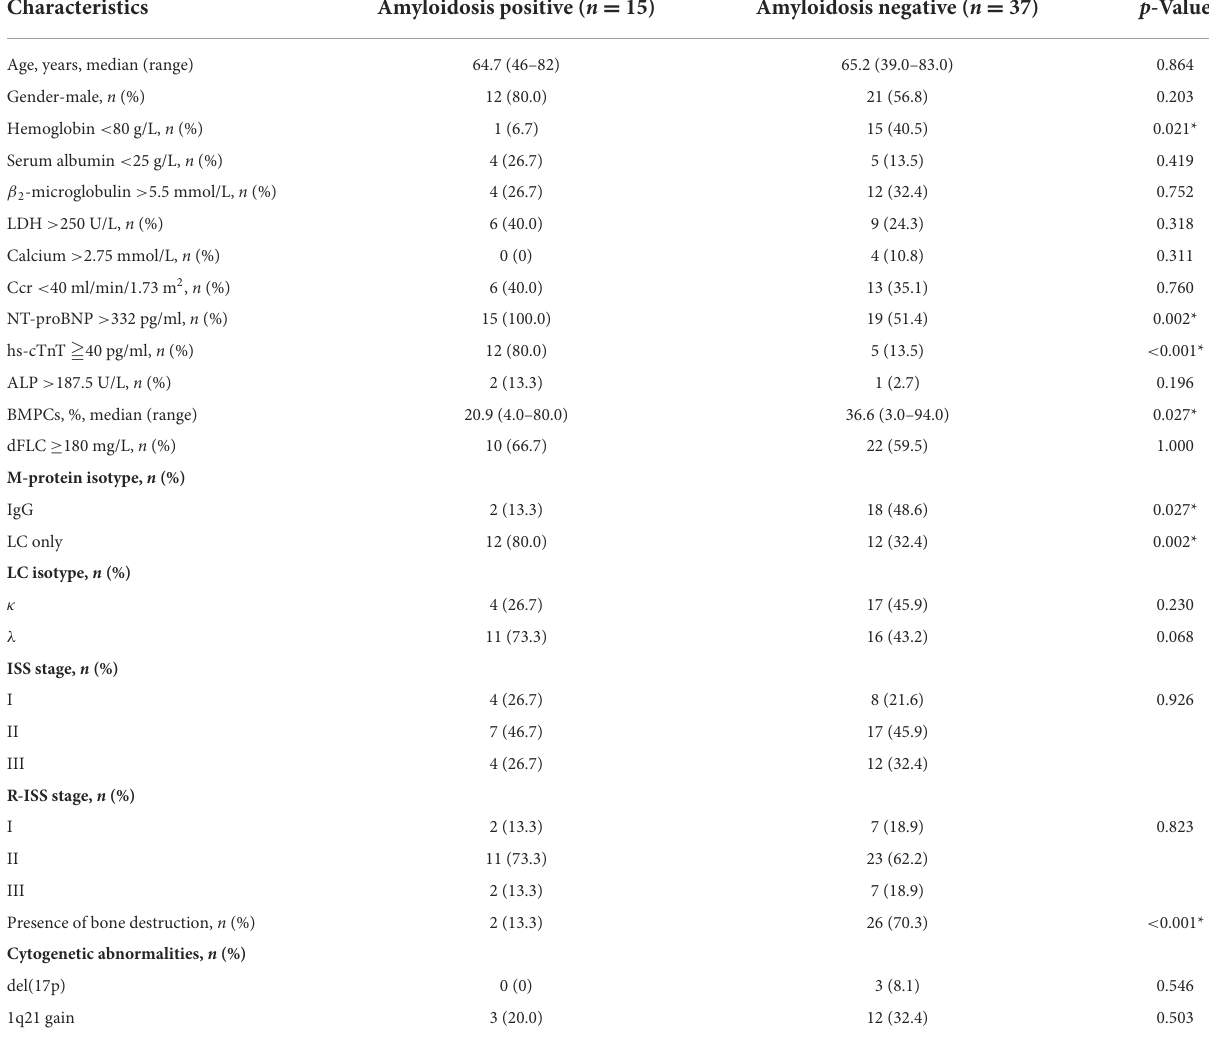
TABLE 2 Baseline characteristics according to the presence or absence of cardiac amyloidosis.